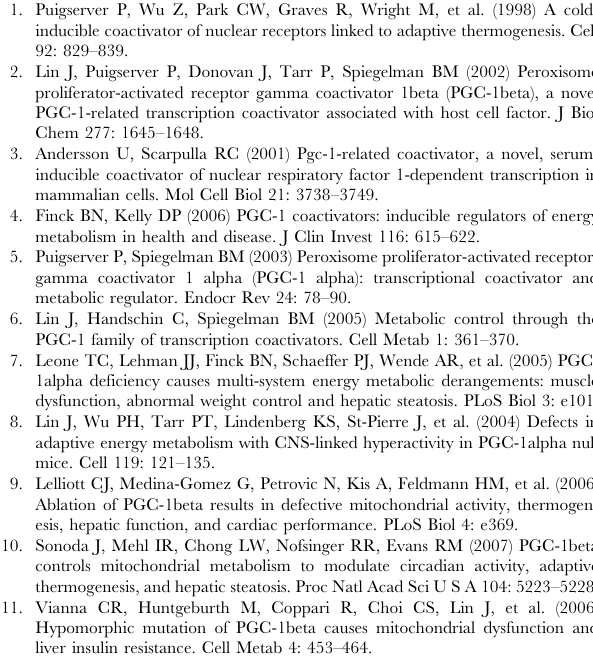
Figure S1 Liver-specific deletion of PGC-1 b . [ A ] The targeting construct and strategy for conditional ablation of PGC- 1 b is schematized. [ B ] The gel at right shows the results of PCR analyses using the P1 and P3 primers in the schematic at left and DNA isolated from liver of 6 week old PGC-1 b fl/fl mice that were expressing Cre recombinase under the control of the liver specific albumin promoter or were non-transgenic for Cre recombinase. Cardiac DNA from one of the transgenic mice is shown as a